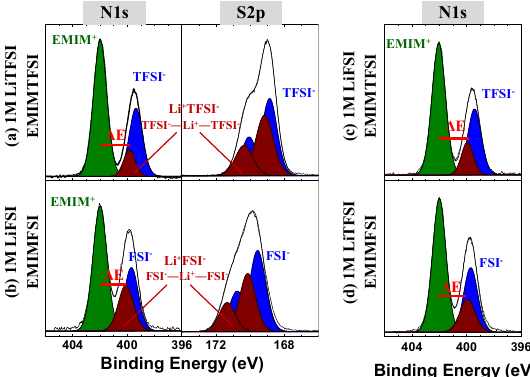
Fig. 3. N1s and S2p XPS core levels acquired on (a)